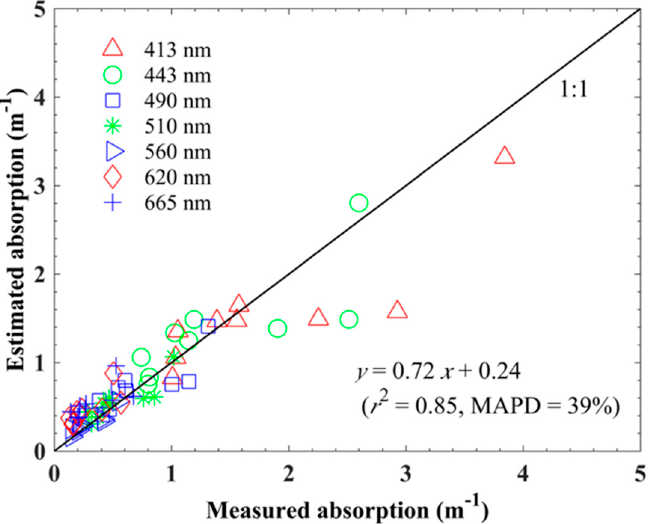
Figure 7. Comparing the estimated and the measured a ( λ ) at MERIS bands using the Lake Erie dataset.